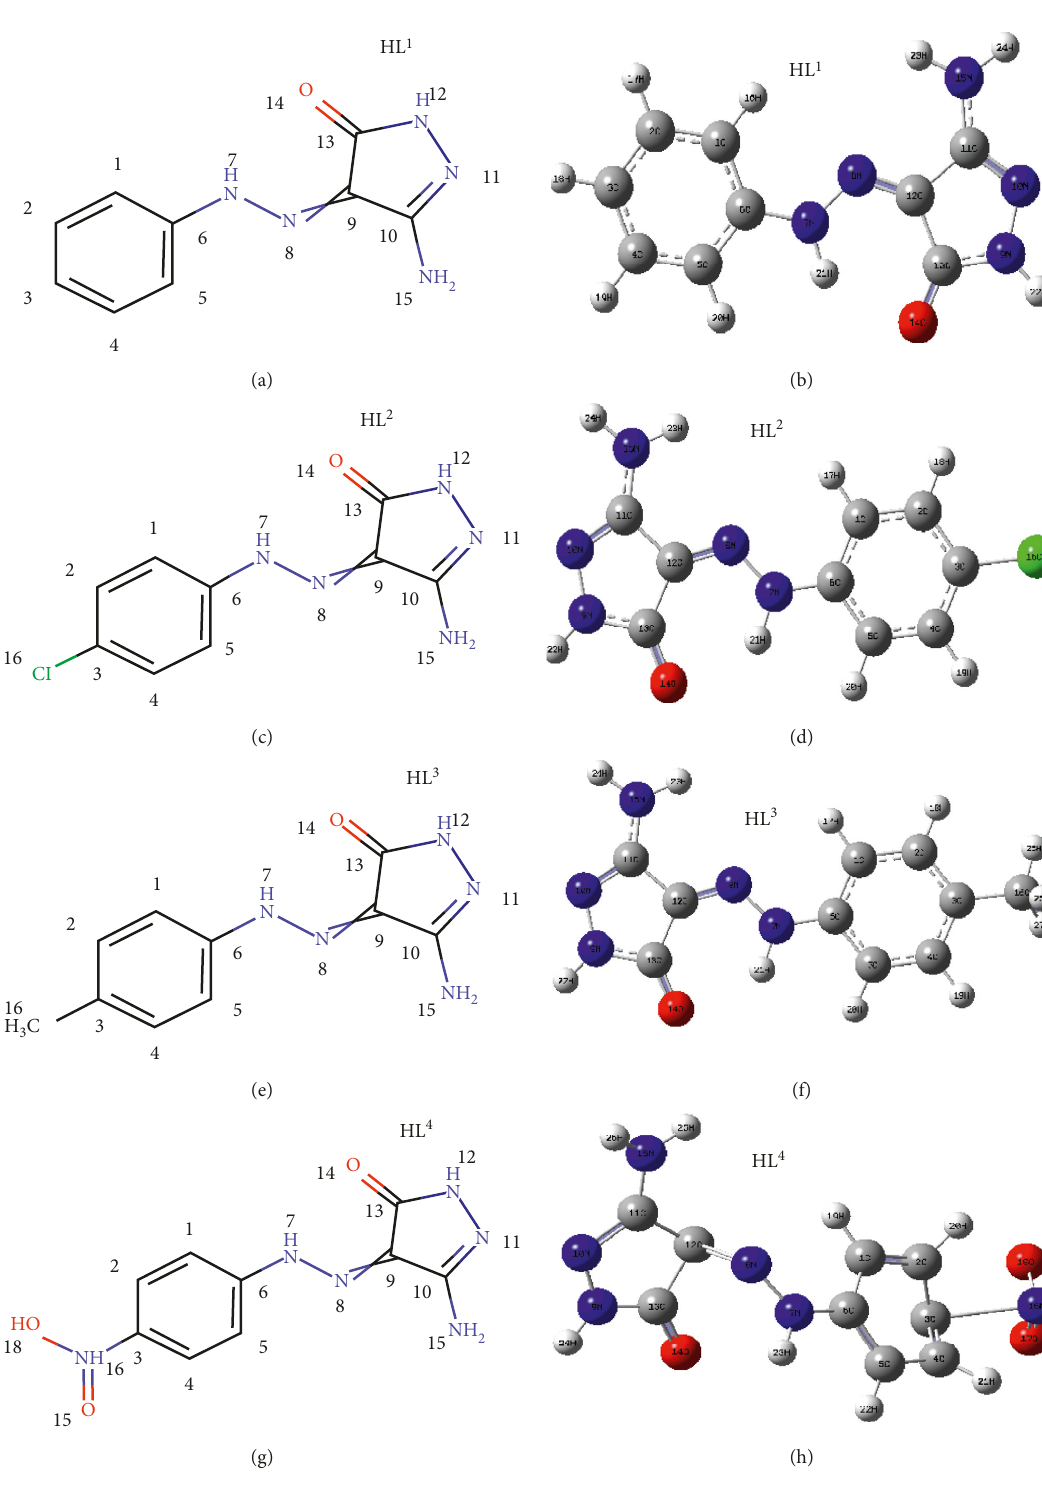
Figure 1: The best structural forms of pyrazolone ligands (HL 1 –HL 4